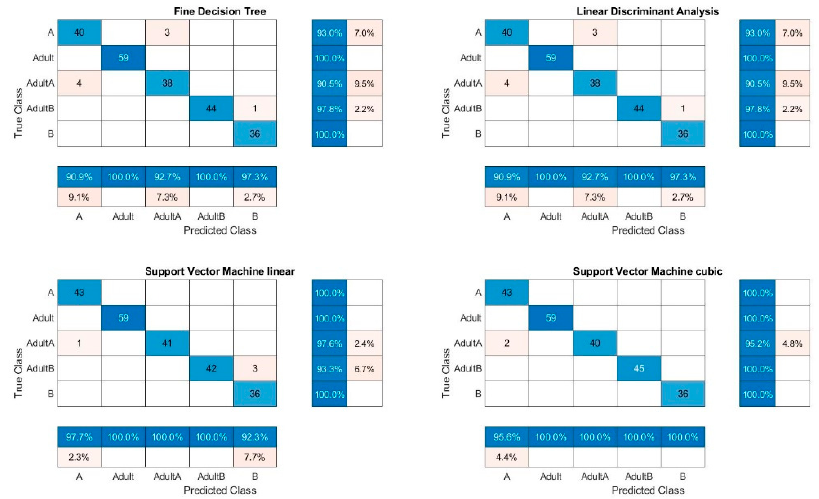
Figure 8. Confusion matrix for the oil classification by DT, LDA, SVMl & SVMc out of the combined evaluation of the fluorescence and NIR spectra. Table 6. Results of the best PLSR predictions for the single oils A and B with single evaluations of the adulteration oils R, S, and C and the combination of all adulterations with the samples all separately for all methods and the combination of all